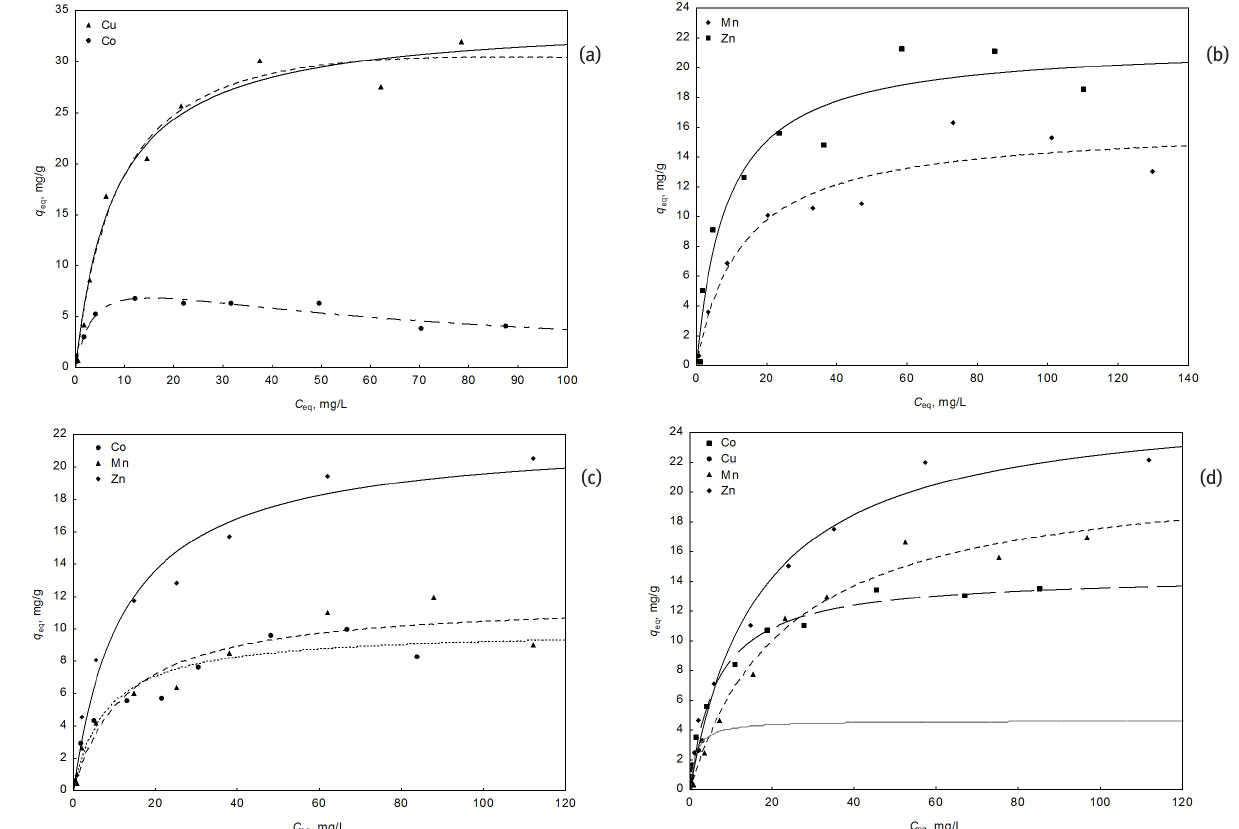
Figure 2: The equilibrium of biosorption process of cations in a) two-cation system Co (II) 0-100 mg L -1 and Cu(II) 0-100 mg L -1 , b) two-cation system Mn(II) 0-100 mg L -1 and Zn(II) 0-100 mg L -1 c) three-cation system Co(II) 0-100 mg L -1 , Mn(II) 0-100 mg L -1 and Zn(II) 0-150 mg L -1